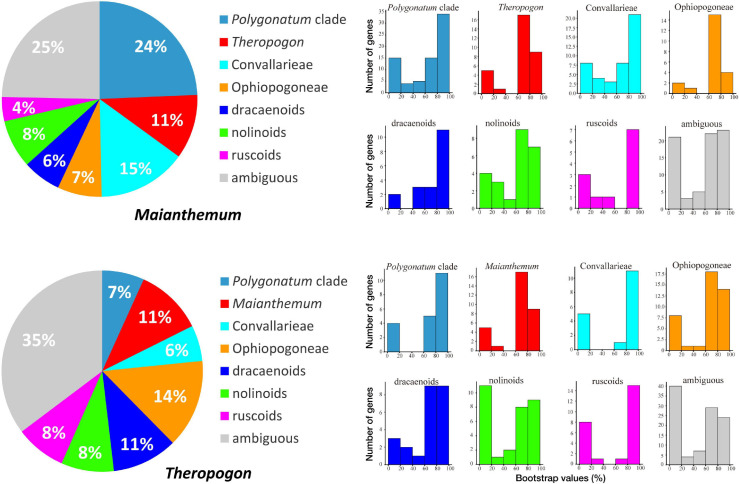
Numbers of individual gene trees supporting different relationships. Pie graphs show the proportions of gene trees with different topologies. Histograms indicate distributions of maximum likelihood (ML) bootstrap supports for the corresponding topologies.